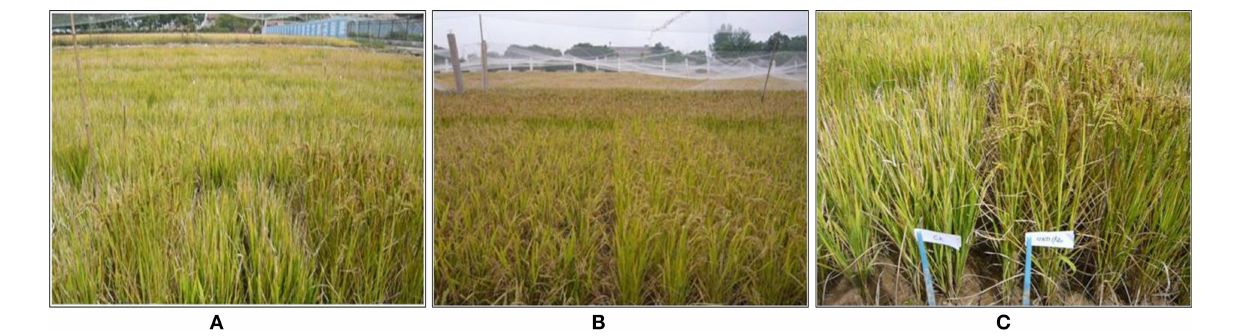
FIGURE 1 | Field screening and performance of drought tolerance under drought stress. (A) The field screening of DT at the reproductive stage. (B) Performance of the DT ILs under drought stress. (C) Comparison of DT IL and JG88 under drought stress (The left side are JG88 and right side are DT